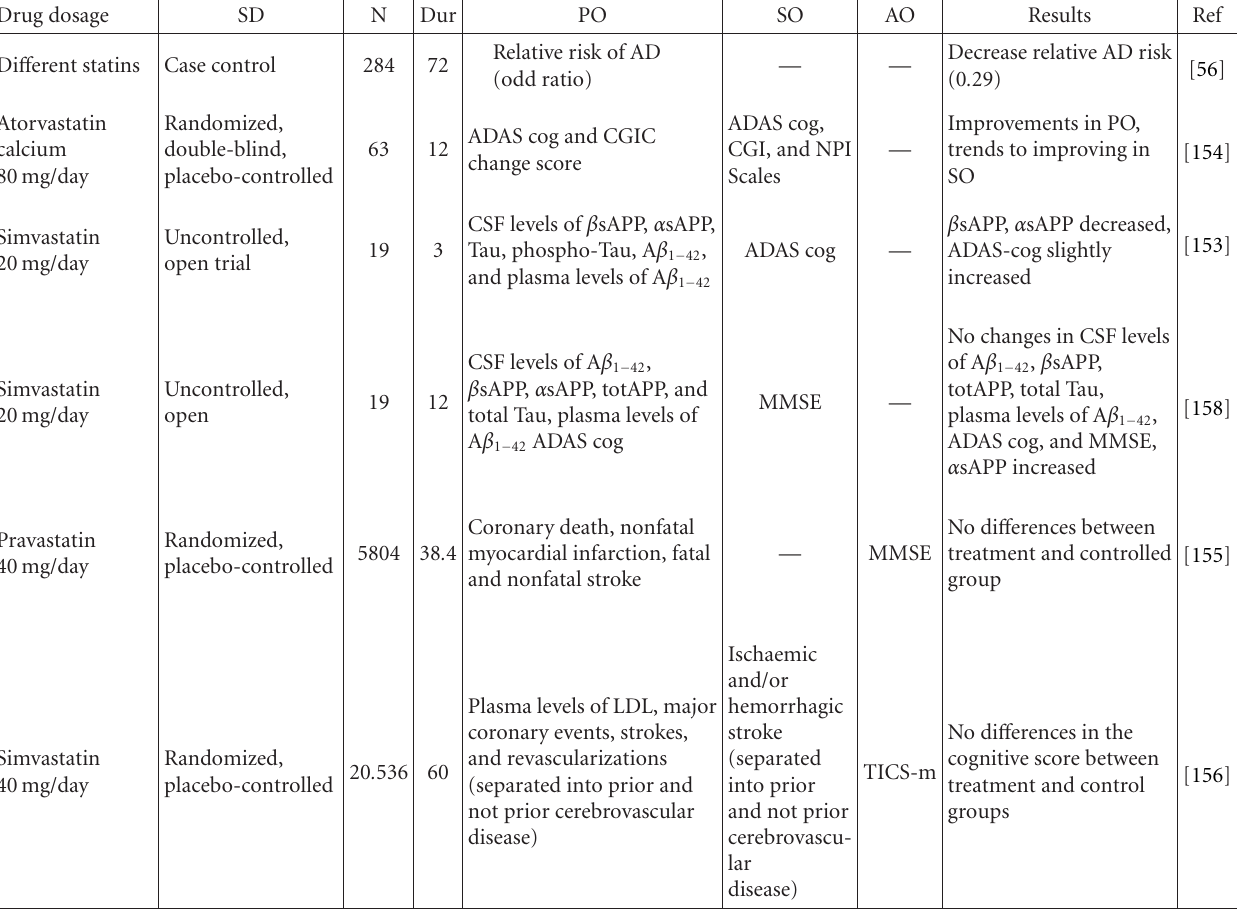
Table 2: Summary of the main clinical studies that have provided statins e ffi cacy results in AD or other types of dementias. Dur: duration of the study (months), N: number of patients, SD: study design, PO: main primary outcomes or biological e ff ects, AO: additional outcomes, SO: main secondary outcomes, Ref: